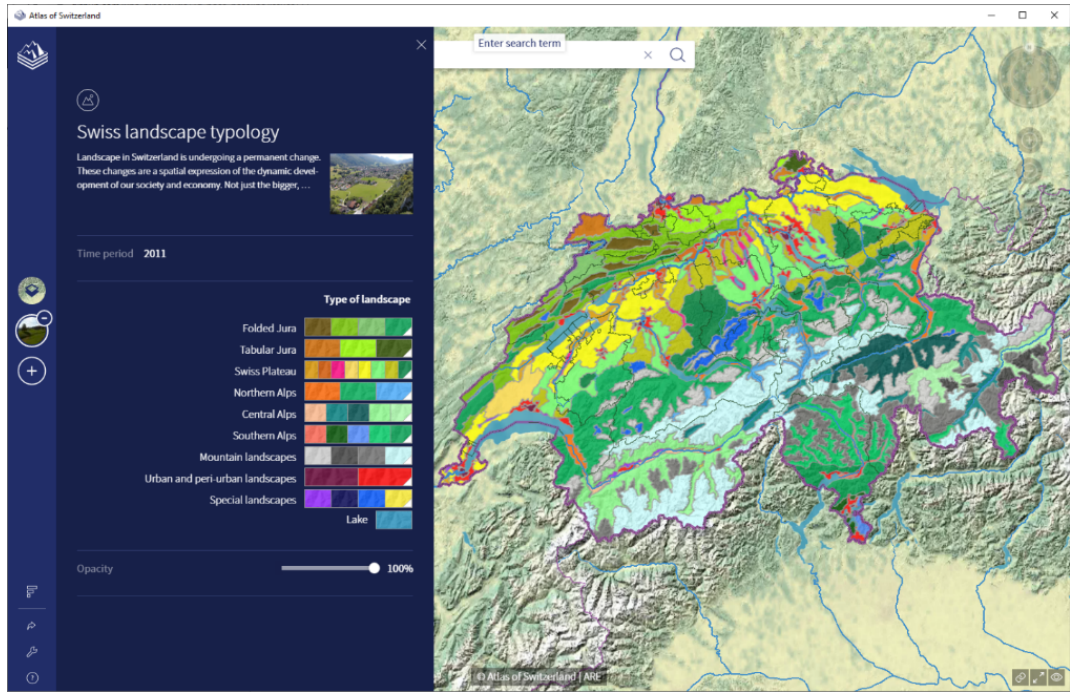
Figure 2. The Swiss landscape typology map from the Atlas of Switzerland—online [17] © 2022 Atlas of Switzerland.